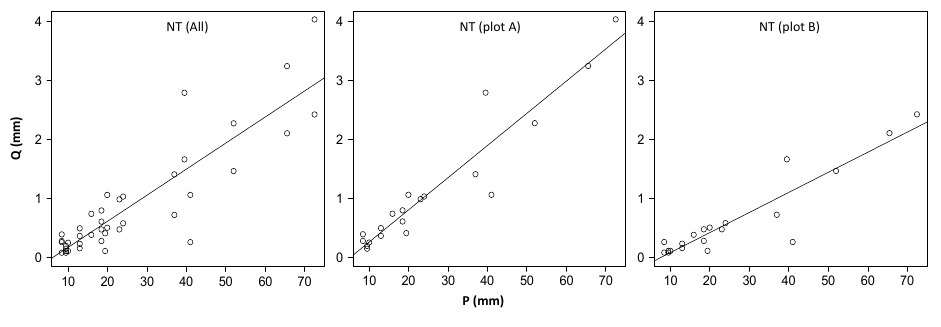
Figure 7. Flow-duration curve of plot A and B in the NT, LRBC, and AC phase. In all phases and in both plots, surface runoff ( Q ) increased linearly with event rainfall ( P ) (Figure 8). In the NT phase, strong linear relationships were found (plot A, R 2 = 0.9019; plot B, R 2 = 0.8488).